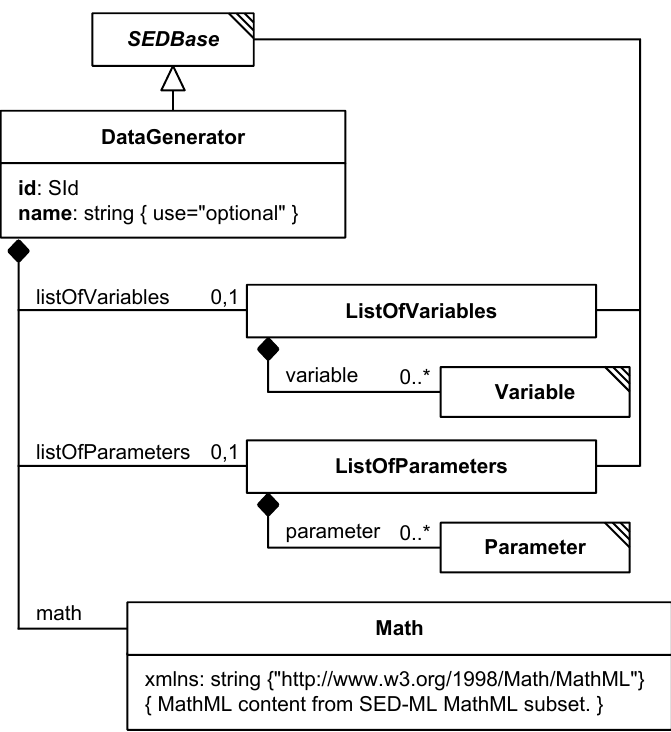
Figure 2.15: The SED-ML DataGenerator class. Note that Parameter and Variable are subclasses of SEDBase ; the respective inheritance connections are not shown in the figure.